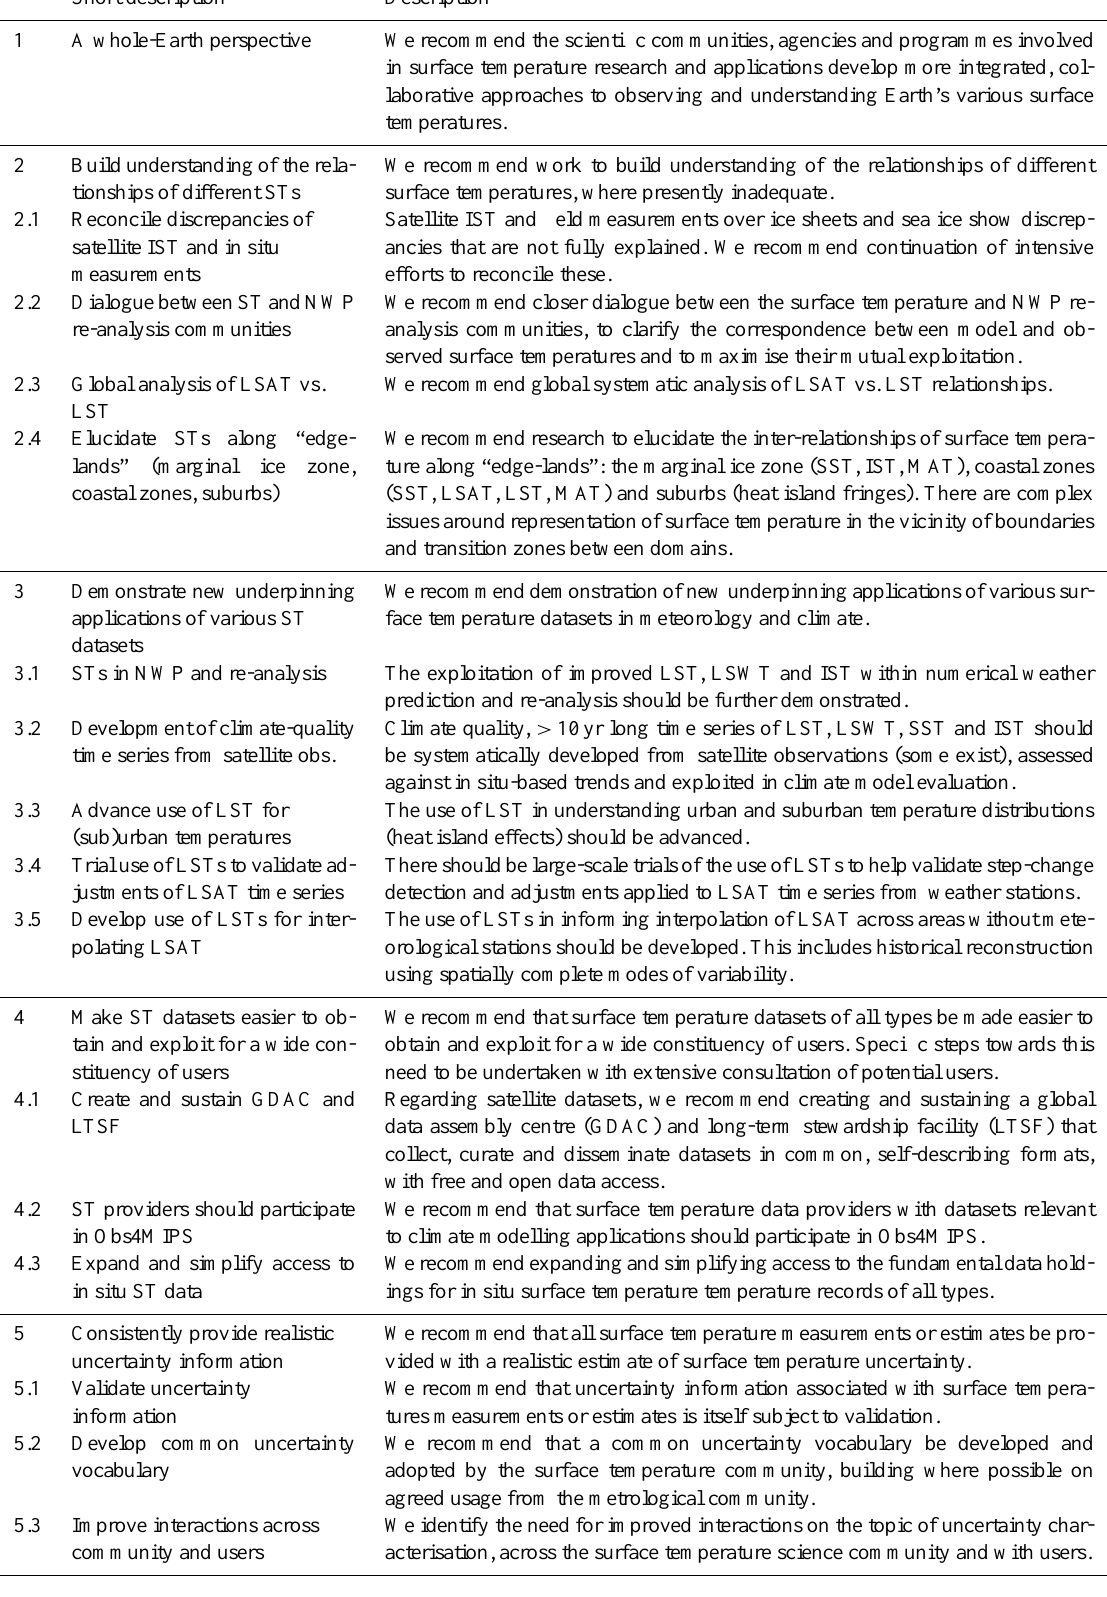
Table 1. The steps recommended in this paper for improving our understanding of Earth’s surface temperatures. Short